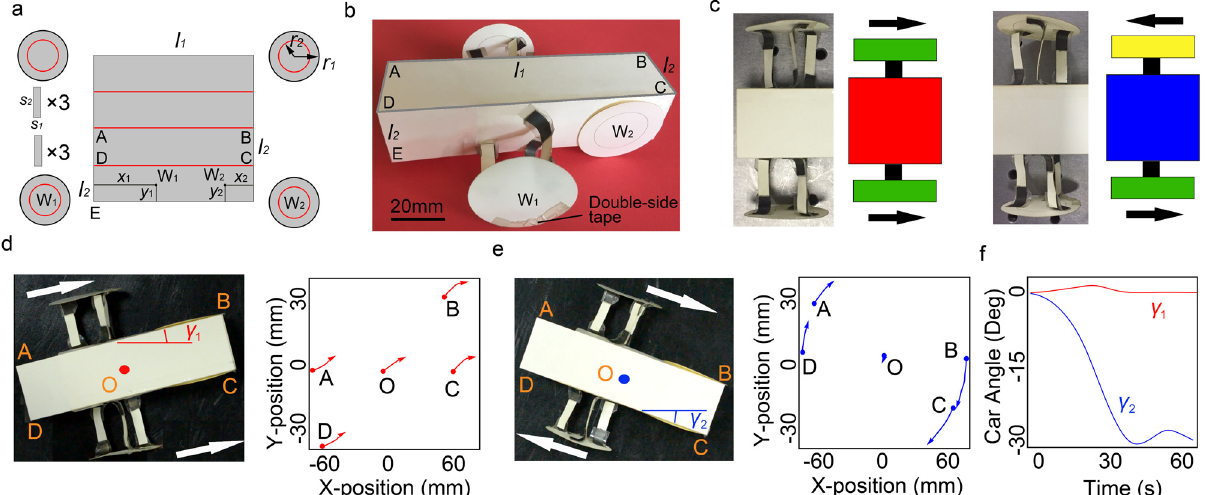
Figure 3: ( a ) 2D design scheme of the car. ( b ) Photograph of the car with heat - driven motors. ( c ) Two action wheels on the two sides of the car twisting ( left ) in identical direction and ( right ) in opposite direction. ( d ) Translational motion of the car ( photograph and red trajectories of the fi ve points on the car surface ) . ( e ) Rotational motion of the car ( photograph and blue trajectories ) . ( f ) Measurements of the car body angles regarding the ( red ) translational motion and ( blue ) rotational